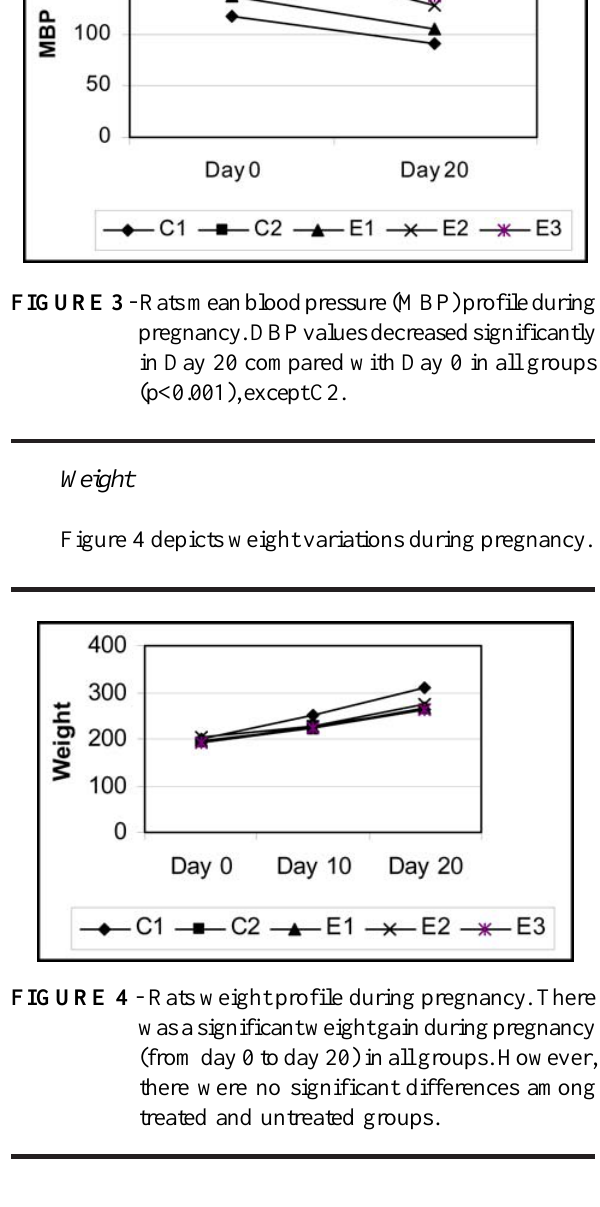
FIGURE 4 - Rats weight profile during pregnancy. There was a significant weight gain during pregnancy (from day 0 to day 20) in all groups. However, there were no significant differences among treated and untreated